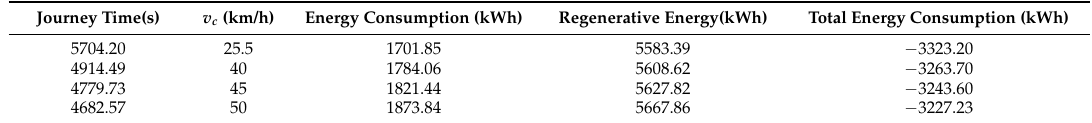
Table 3. Simulation results under different journey time.